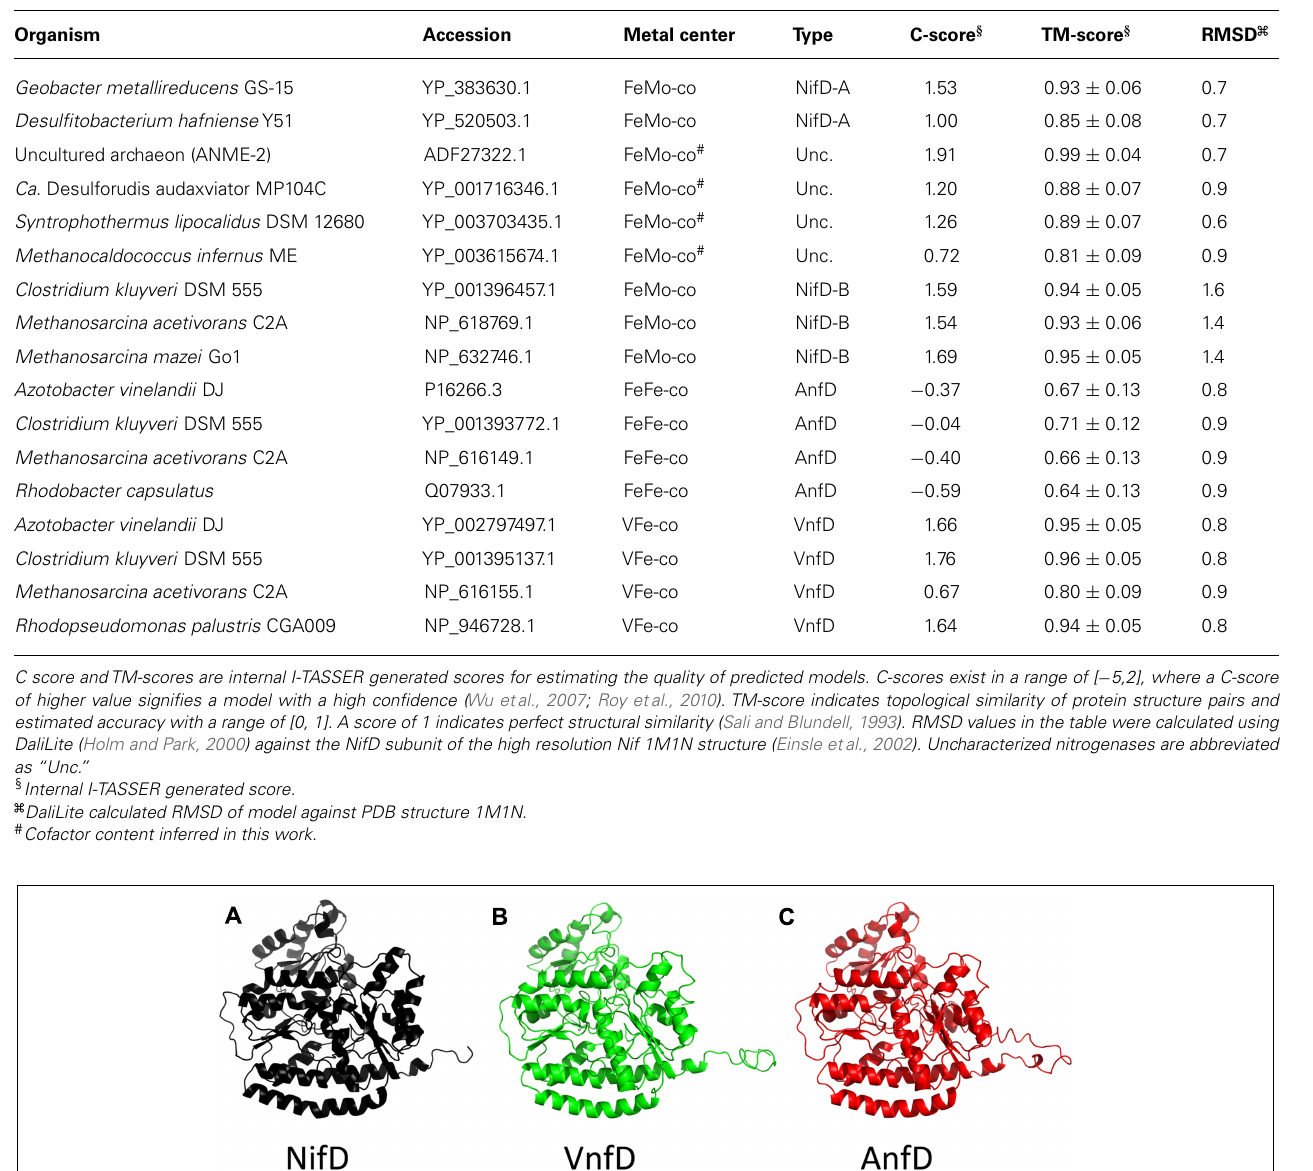
Table 1 | Protein structure modeling statistics.